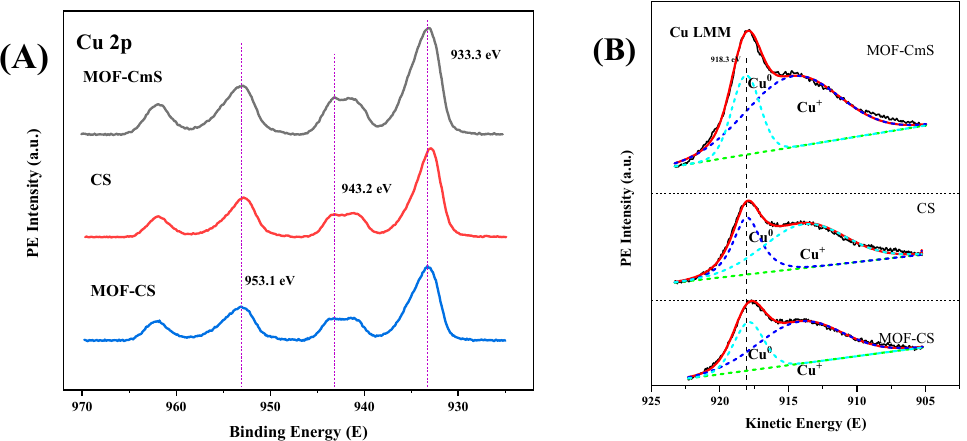
Figure 4. ( A ) Cu 2p XPS spectra and ( B ) Cu LMM XAES spectra of reduced MOF-CS, CS, and MOF-CmS samples .